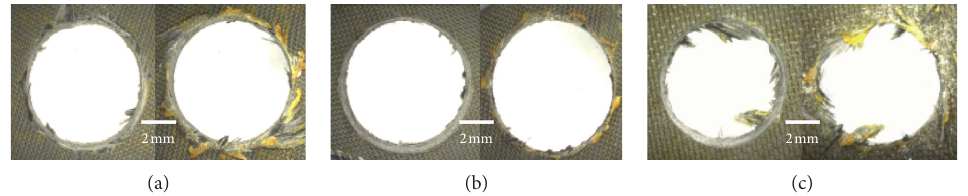
Figure 13: The photos of holes drilled by each drill. (a) a